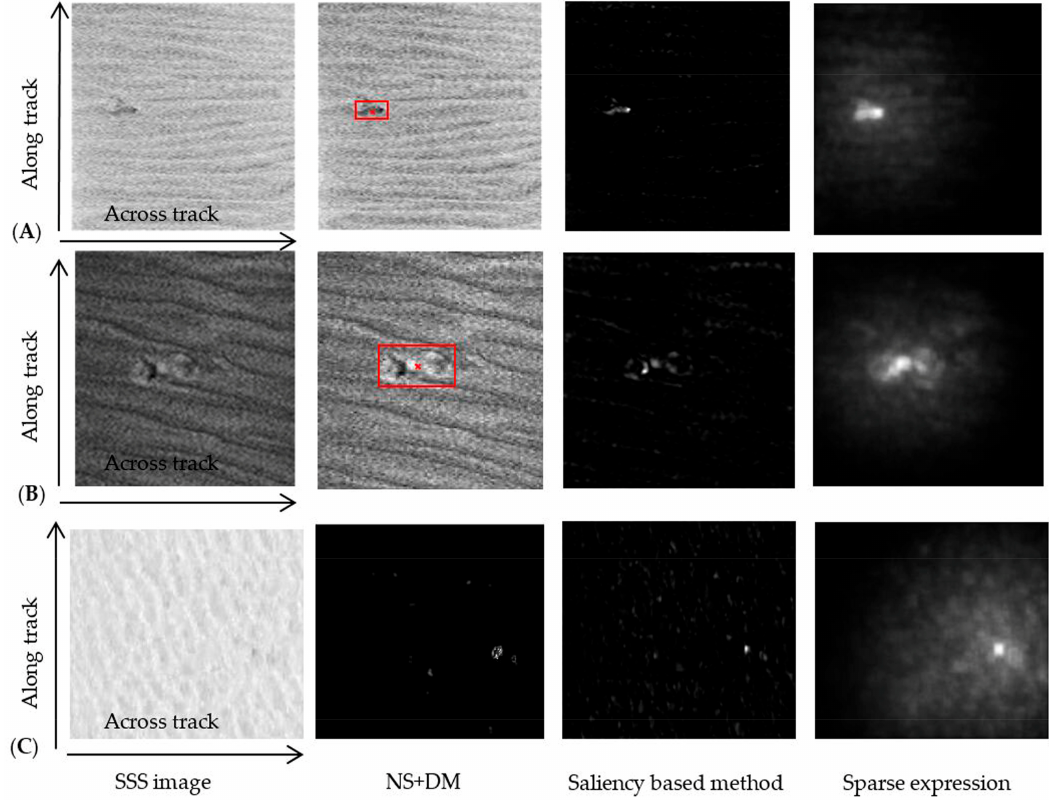
Figure 15. The target detection results in SSS images of sand wave terrain by different methods. ( A ), ( B ) and ( C ) indicate 3 different segment images of the surveyed